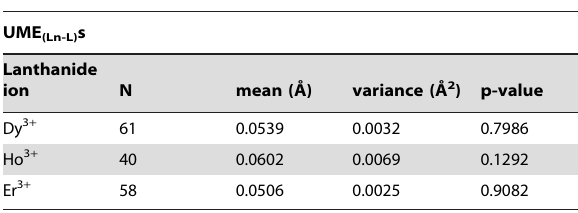
Table 5. Means and variances for the c distribution fits of the UME (Ln-L) s computed for the N complexes for each lanthanide